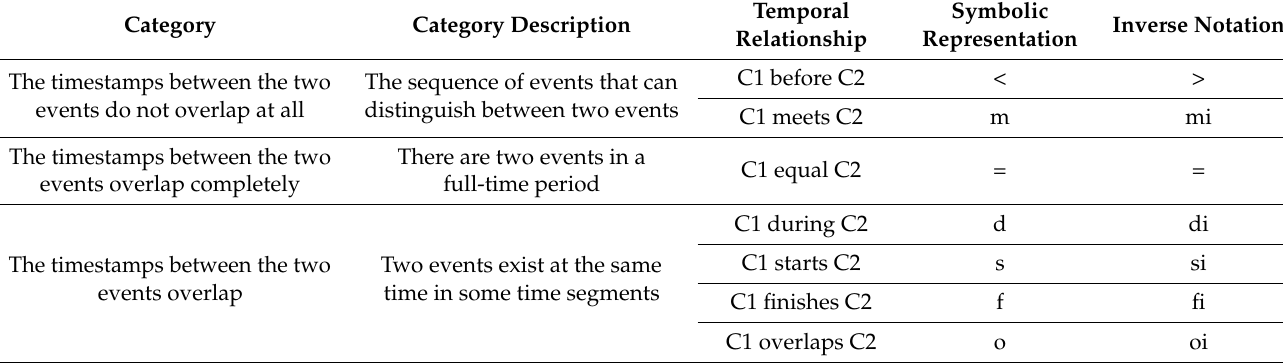
Table A2. Interval timestamp relationships.